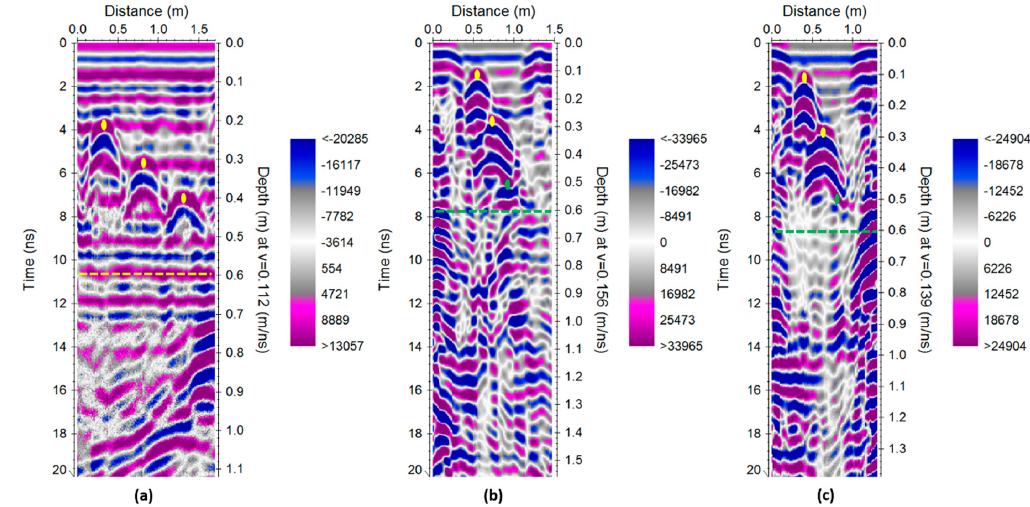
Figure 9. GPR sections in air-dried soil boxes from the laboratory irrigation experiments with a central frequency of 800 MHz. ( a ) Grumusol; ( b ) hamra; ( c ) loess. In the small loess soil box, changes in EM velocity due to increasing water content were observed and calculated from the GPR sections, with some shown in Figure 10. The added distilled water in those sections was: 0 (air-dried), 25.00 ± 0.63 L, 55.00 ± 1.38 L, and 80.00 ± 2.00 L. The average measured EM velocities were 0.139 ± 0.007 m/ns (air-dried), 0.093 ± 0.003 m/ns, 0.074 ± 0.002 m/ns, and 0.064 ± 0.001 m/ns, respectively. The bulk dielectric constants calculated from those velocities were: 4.63 ± 0.46, 10.33 ± 0.68, 16.31 ± 0.86, and 22.11 ± 1.00, respectively, and the moisture contents